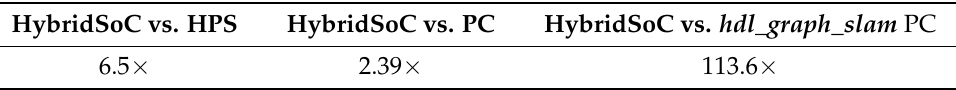
Table 2. Average Acceleration Factor of eSoC-LAM running in a Cyclone V SoC device at 50 Mhz. HybridSoC vs.